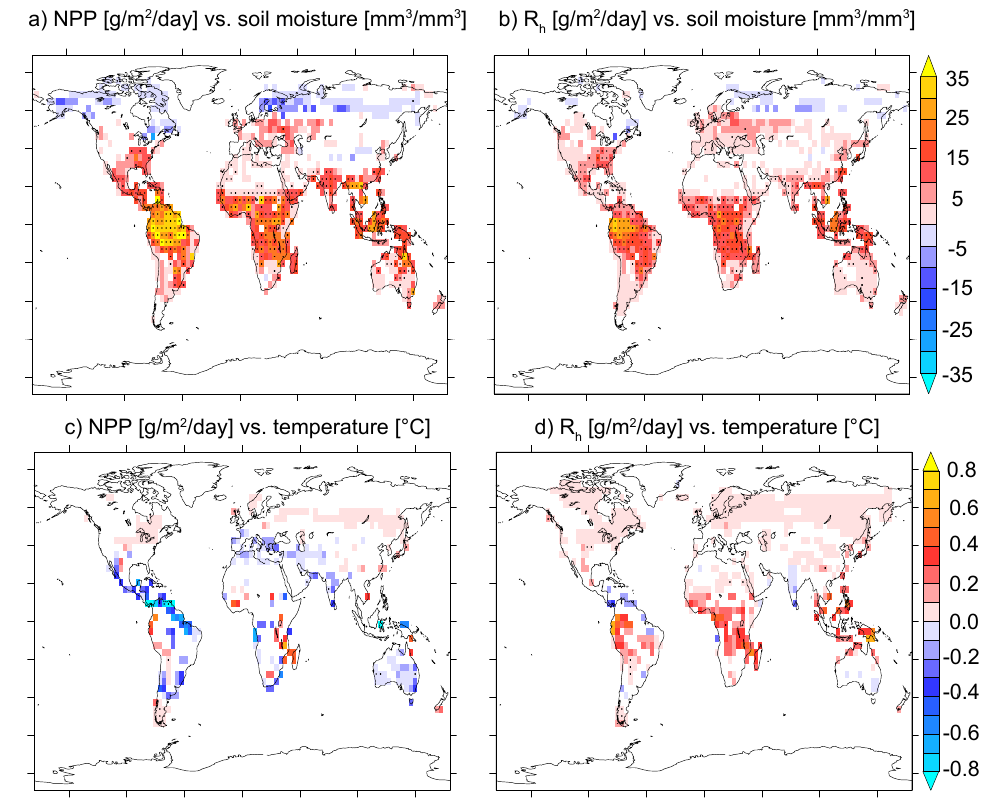
Fig. 7. Linear regression analysis of deseasonalized NPP (a, c) and R h (b, d) on (a, b) deseasonalized soil moisture and (c, d) surface temperature for the Pin.10x case. Color shading represents the sensitivity of NPP and R h to these variables (slopes of the linear regression). The regressions have been calculated over the first 5yr and only grid cells where r 2 > 0 . 1 are shown. Stippling denotes correlations with r 2 > 0 .